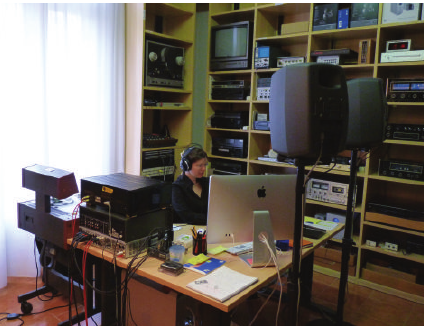
Figure 10: Laboratory for the preservation and the restoration of audio documents inside the audiovisual archive of the Fondazione Arena di Verona. On the right, a large collection of recording/replay devices can be observed on the shelves. On the left, an open-reel recorder Studer A812. On the desk, an A/D-D/A Converter PRISM ADA-8XR and two Compact Cassette recorders.